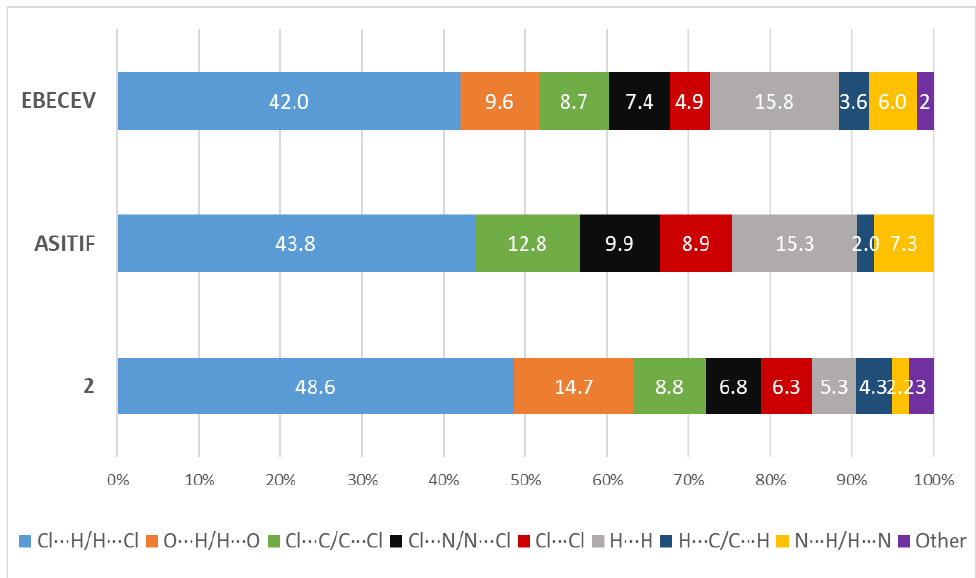
Figure 11. Percentage contributions of contacts to the Hirschfeld surface in structures 2 and taken from CSD. ASITIF: Pentachloro-(9-methyladeninio-N)-platinum(IV) [32]; N-Methylmethanaminium pentachl ro-(5-methyl[1,2,4]triazolo[1,5-a]pyrimidin-7(4H)-one)-platinum(IV) [56].